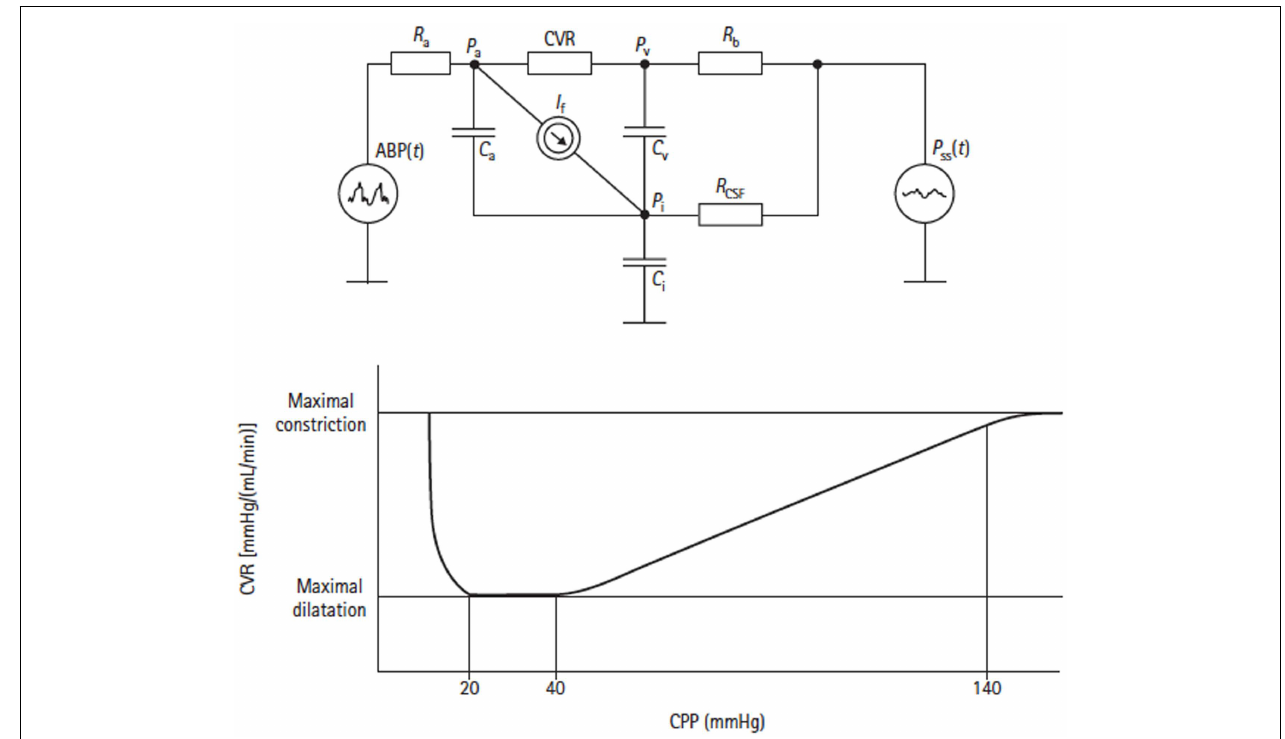
arteries ( P a ), pressure in the cortical veins ( P v ), ICP ( P i ), sagital sinus pressure ( P ss ), resistance of great cerebral arteries ( R a ), cerebrovascular resistance (CVR), resistance of cortical and bridging veins ( R b ), CSF outflow resistance ( R CSF ), and CSF secretion ( I t ).The lower figure shows the autoregulatory relationship between CVR and CPP as predicted by the model.